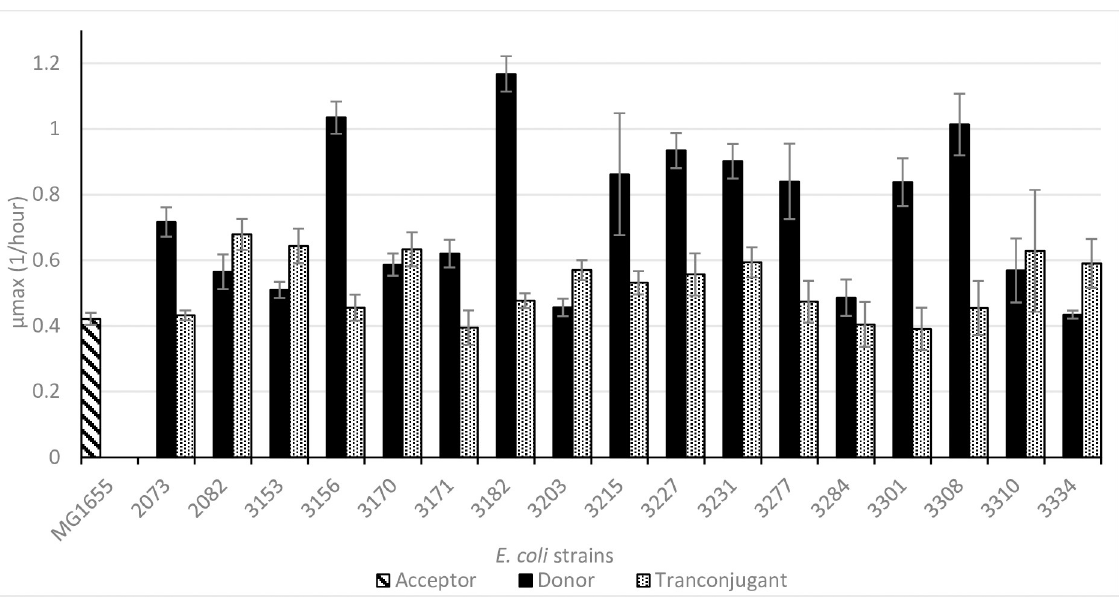
Fig 2. Average μ max (h -1 ) per recipient (diagonal stripes), donor (solid) and transconjugant (dots) strain with standard deviation. Average values were determined from at least 2 replicates, that individually were measured 8 times. https://doi.org/10.1371/journal.pone.0270205.g002 PLOS ONE | https://doi.org/10.1371/journal.pone.0270205 July 7,